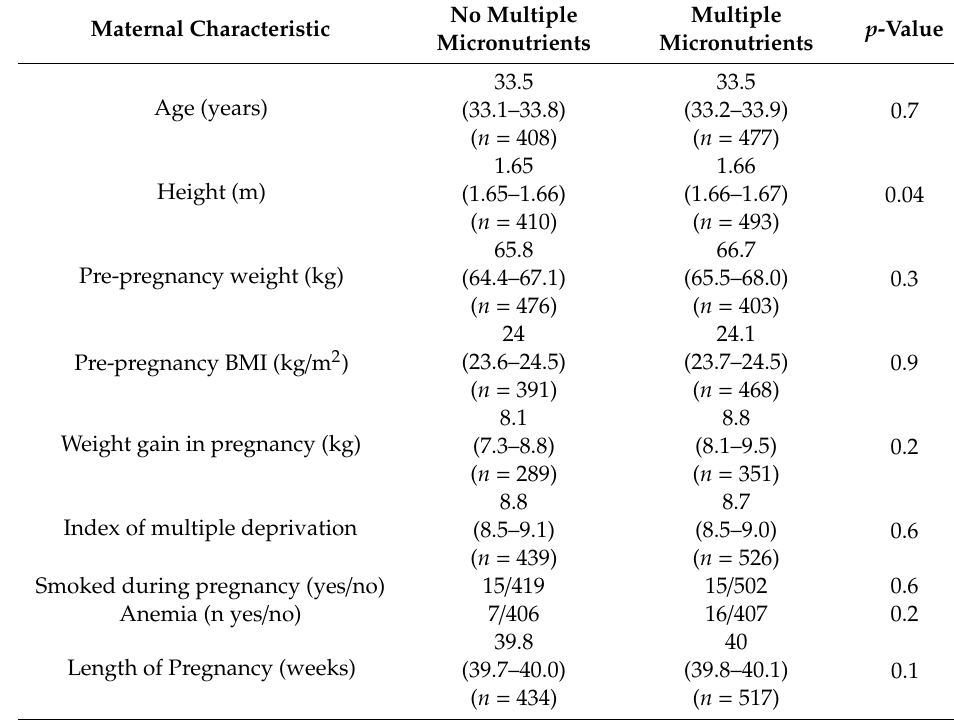
Table 1. A comparison of the characteristics of CBGS maternal participants who supplemented their diets with multiple micronutrients during pregnancy and those that did